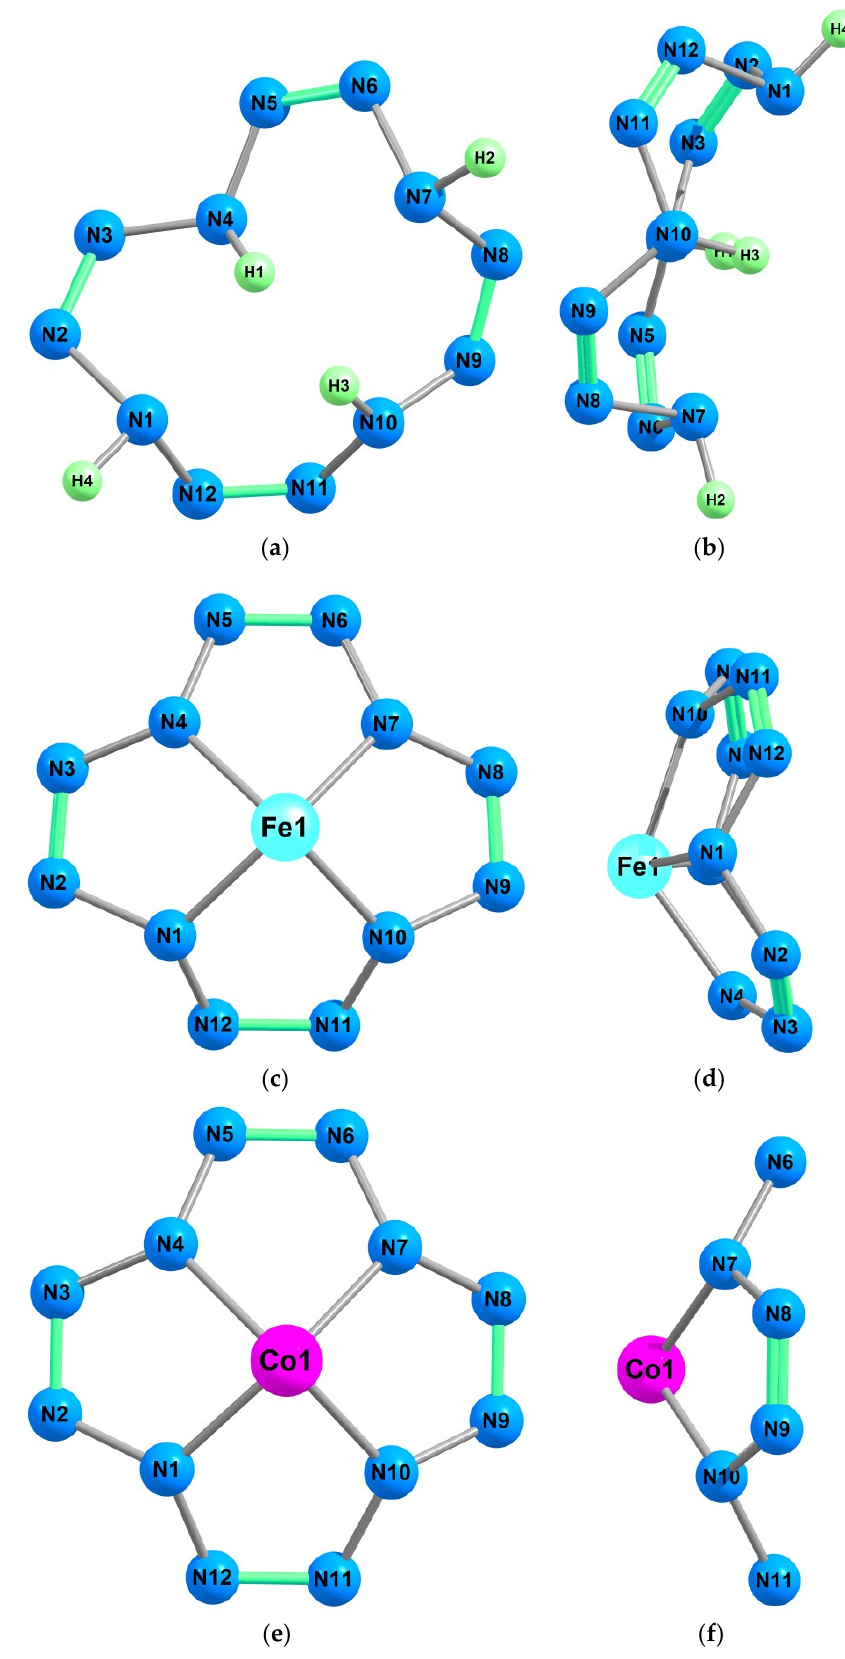
Figure 1. Molecular structures of the compounds H 4 (N 12 ) ( a , b ), Fe(N 12 ) ( c , d ) and Co(N 12 ) ( e , f ) obtained as a result of DFT M06/TZVP quantum chemical calculation: front view ( a , c , e ), side view ( b , d , f ). Table 1. Key parameters of molecular structures of M(N 12 ) compounds calculated by DFT M06/TZVP method.